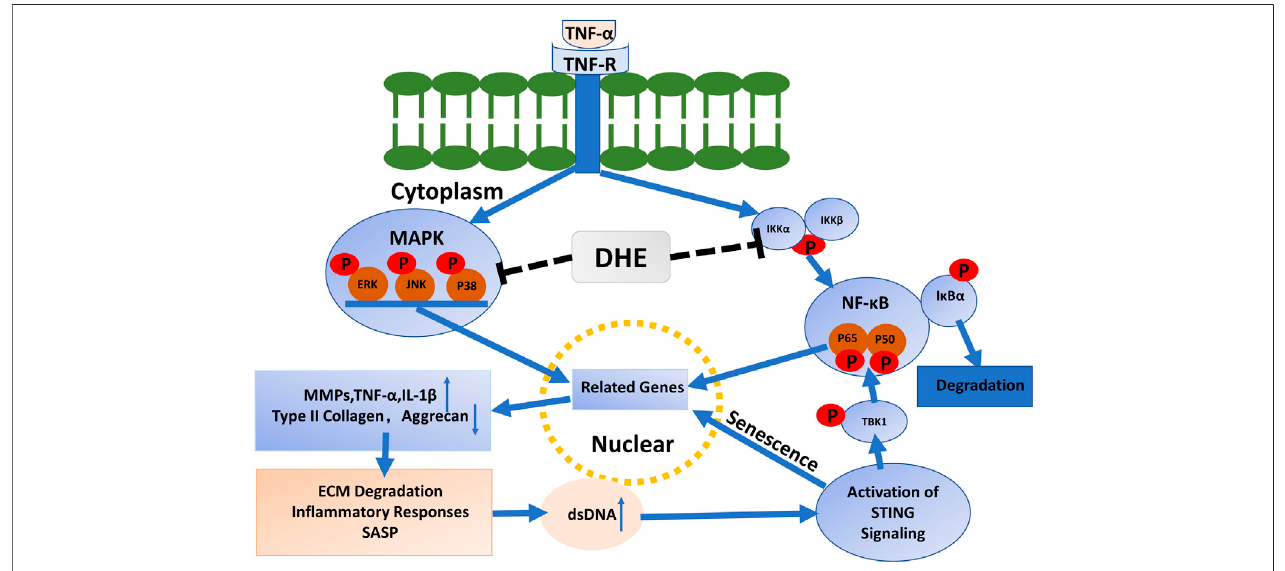
FIGURE 5 | Mechanisms driving the effects of dehydrocostus lactone (DHE) in tumor necrosis factor- α (TNF- α ) – induced cellular senescence and in fl ammatory responses in nucleus pulposus (NP) cells.